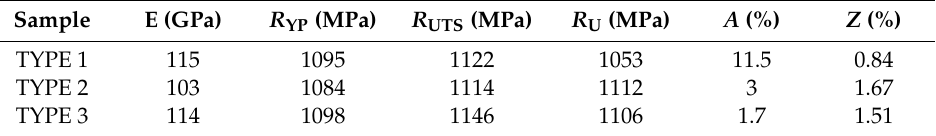
Table 3. Monotonic material parameters of titanium samples